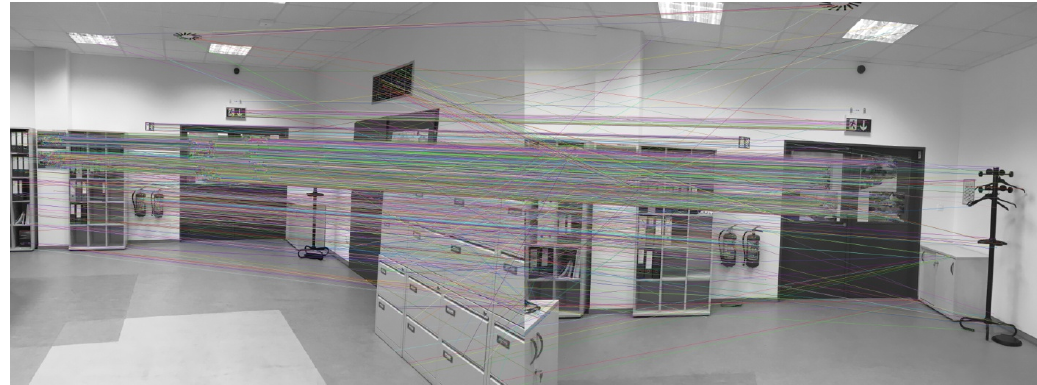
Figure 6. Feature correspondences between input and database image.